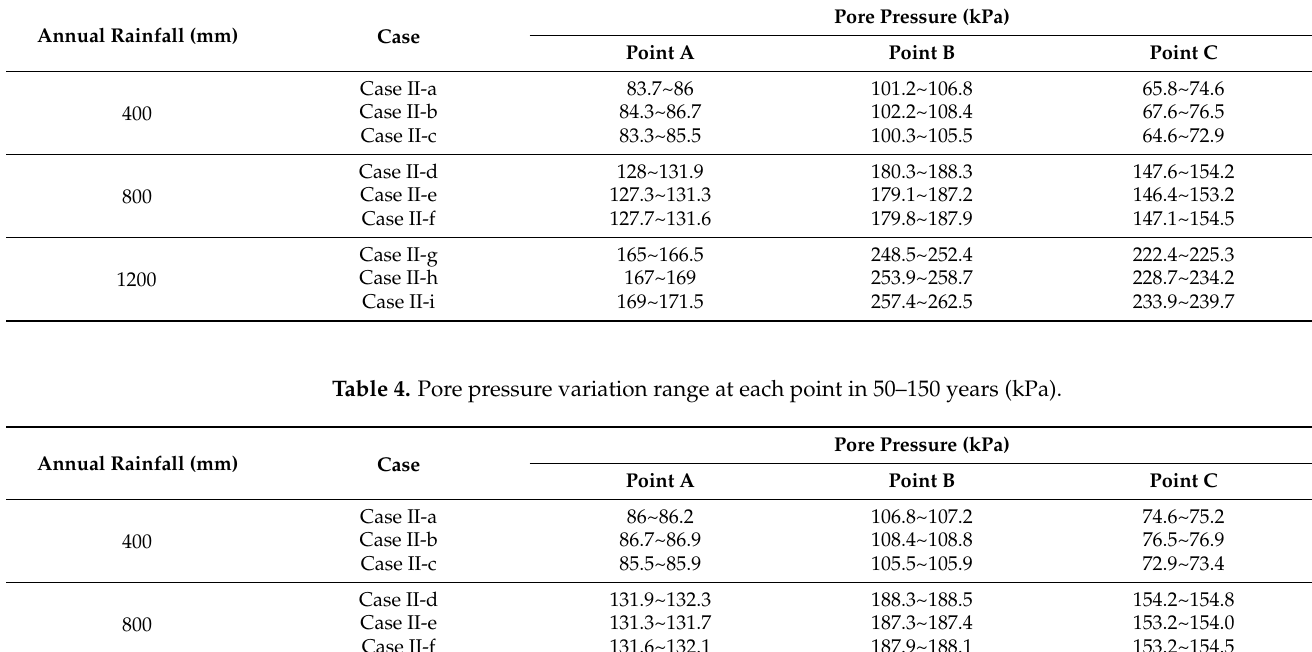
Table 3. Pore pressure variation range at each point in 20–50 years (kPa).